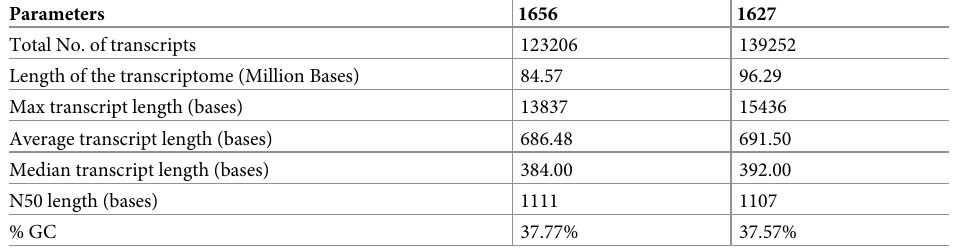
Table 1. Primary and final assembly statistics of 1656 and 1627 in control and drought stress treated onion libraries.